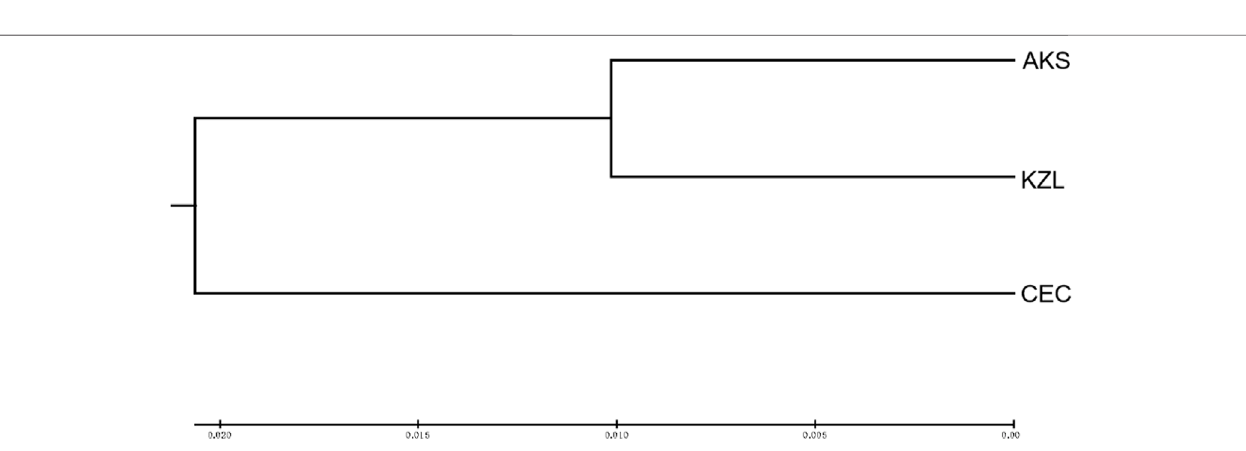
FIGURE 4 | UPGMA clustering tree of 3 populations of Schizothorax biddulphi